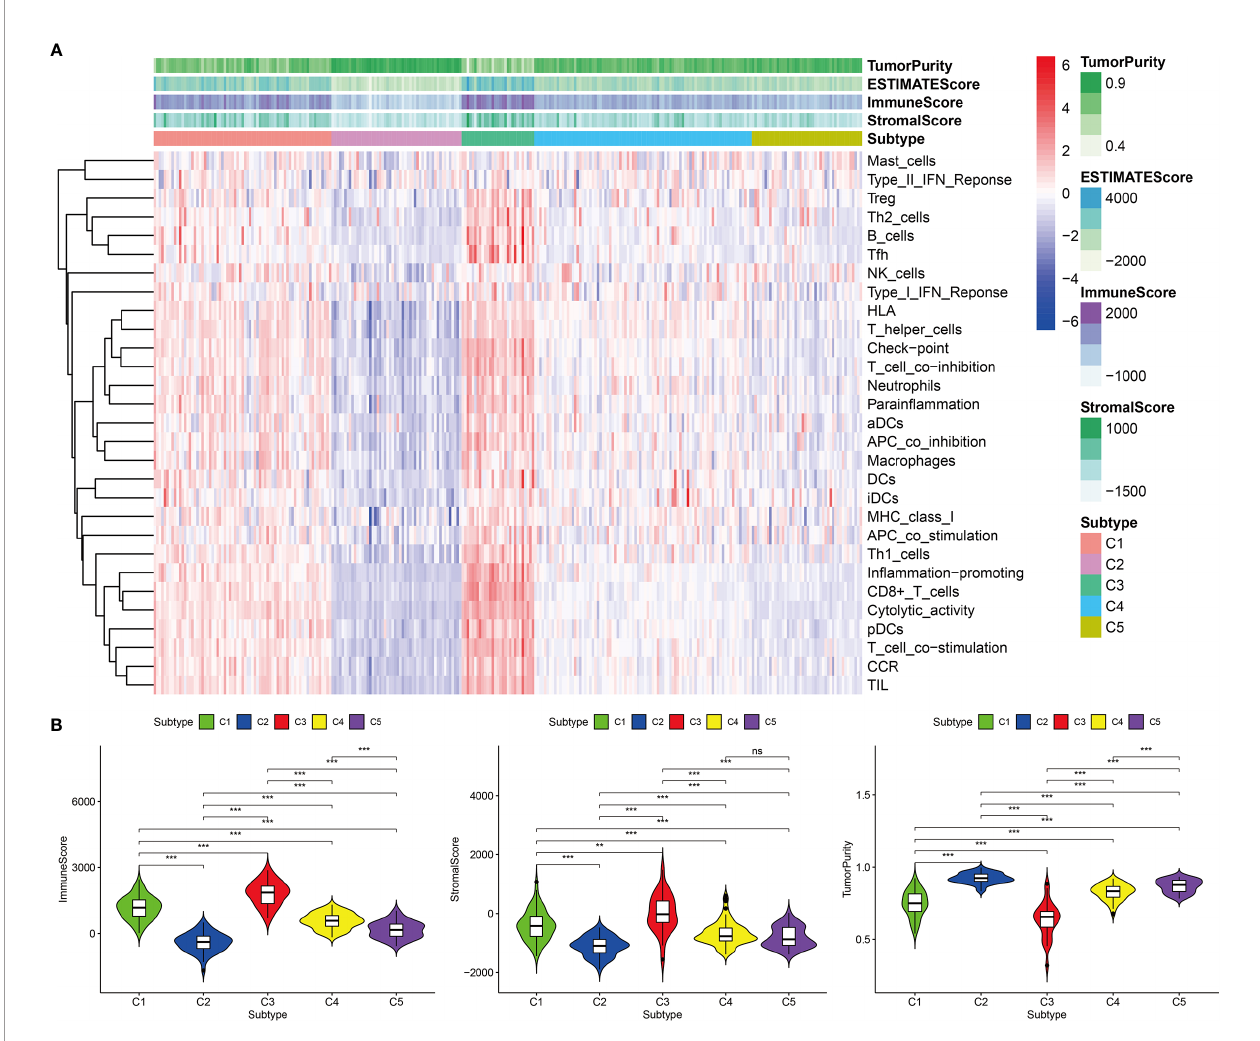
FIGURE 6 | Immune components of fi ve immune subtypes in the TCGA cohort. (A) Heat map of 29 immune gene sets of fi ve immune subtypes. (B) The immune score, stromal score and tumor purity of fi ve immune subtypes, ***p < 0.001, **p < 0.01, ns p >